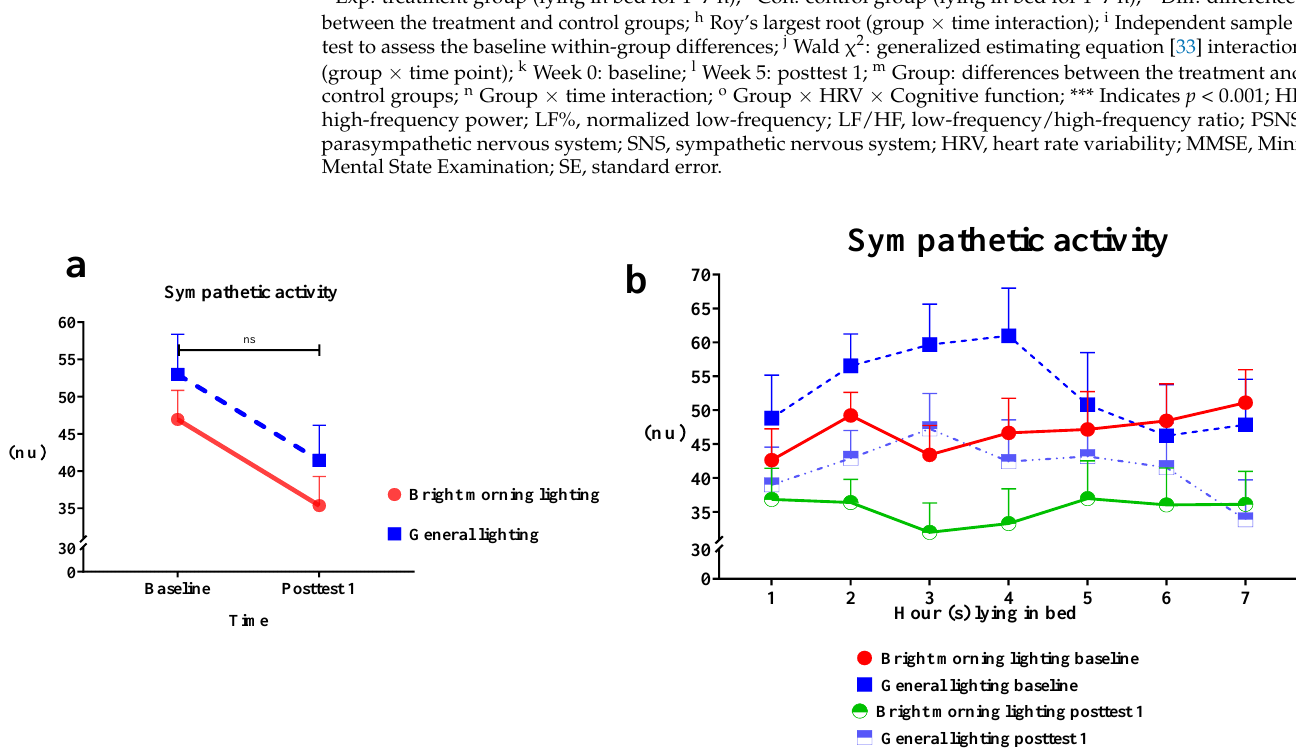
Figure 4. ( a ) Changes in sympathetic nervous system (SNS) activity in the treatment and control groups while lying in bed for 7 h. The treatment group exhibited a nonsignificant decrease ( p > 0.05). ( b ) The BML group exhibited a significant decrease in LF% power while lying in bed for 2–3 h. A U-shaped curve was exhibited at posttest 1.